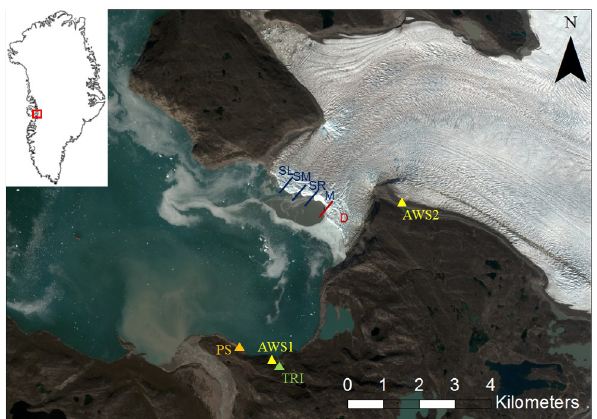
Figure 2. The terrestrial radar interferometer (TRI) located oppo- site of the front of Eqip Sermia at a distance of 4.5km (image: M. Lüthi, 2016). The TRI has one transmitting (TX) and two receiving antennae (RX1,